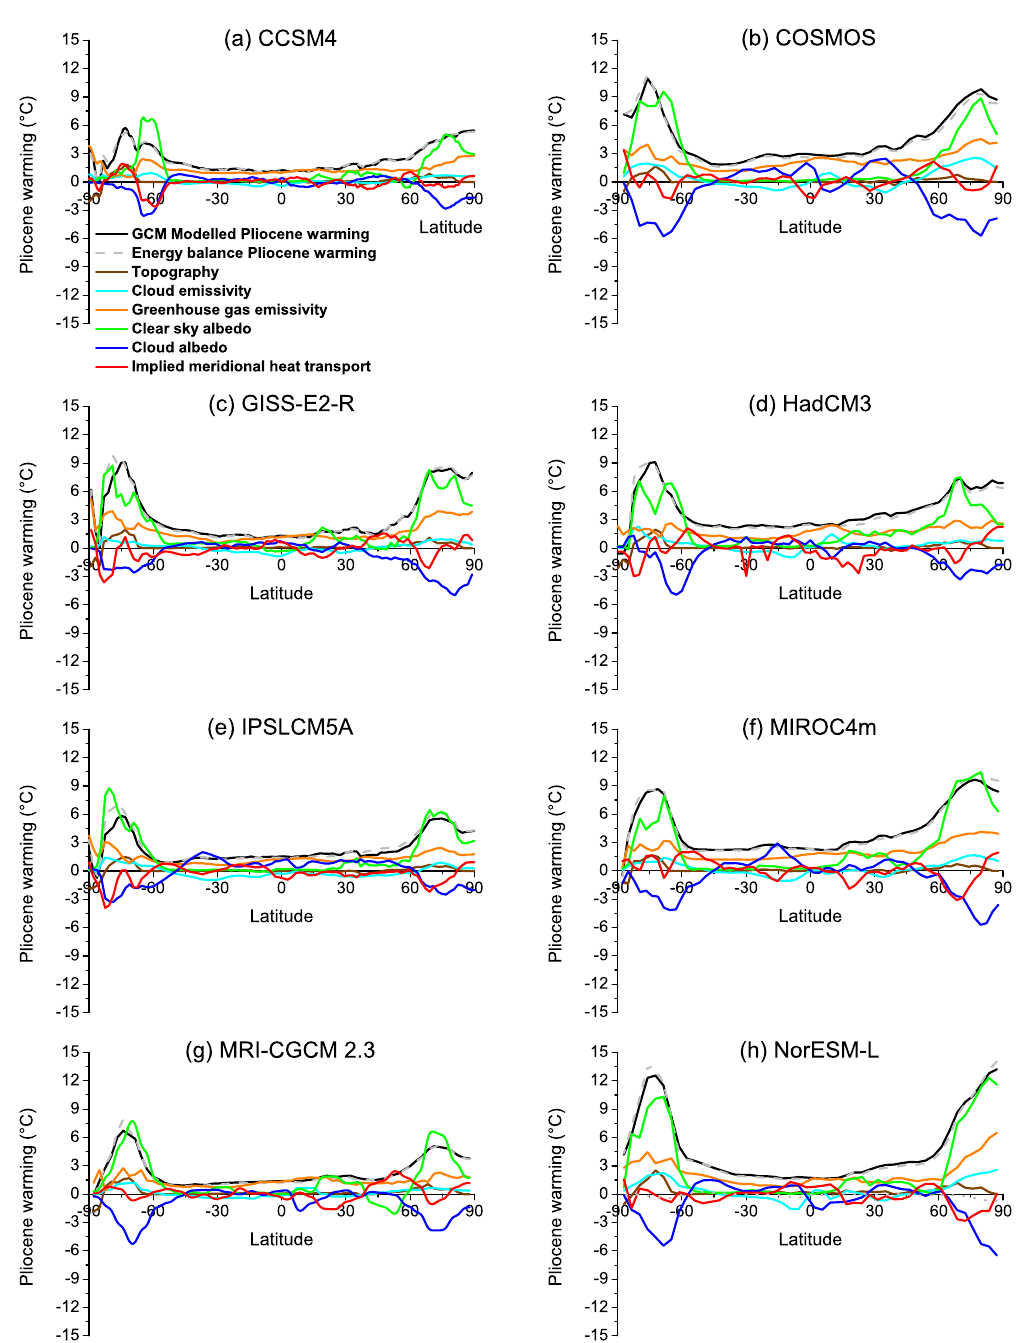
Fig. 3. Energy balance analysis for each of the eight PlioMIP Experiment 2 simulations, from (a) CCSM4, (b) COSMOS, (c) GISS-E2-R, (d) HadCM3, (e) IPSLCM5A, (f) MIROC4m, (g) MRI-CGCM 2.3 and (h) NorESM-L. Plots show the zonal mean warming, at each latitude in the model, from each of the energy balance components. The solid black line is the zonal mean surface air temperature increase from the GCM simulation, while the dashed grey line is the Pliocene warming approximated by the energy balance calculations.